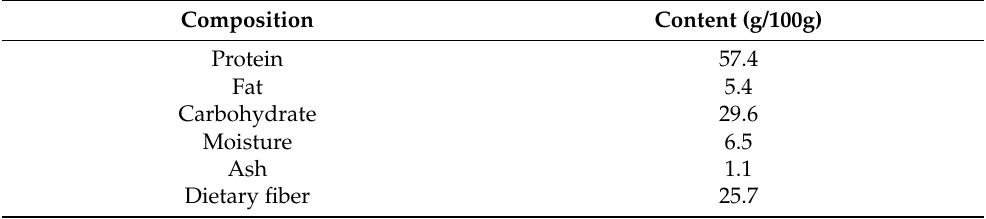
Table 1. Composition of ISLCs. The content of the components in 100 g of ISLCs are shown.